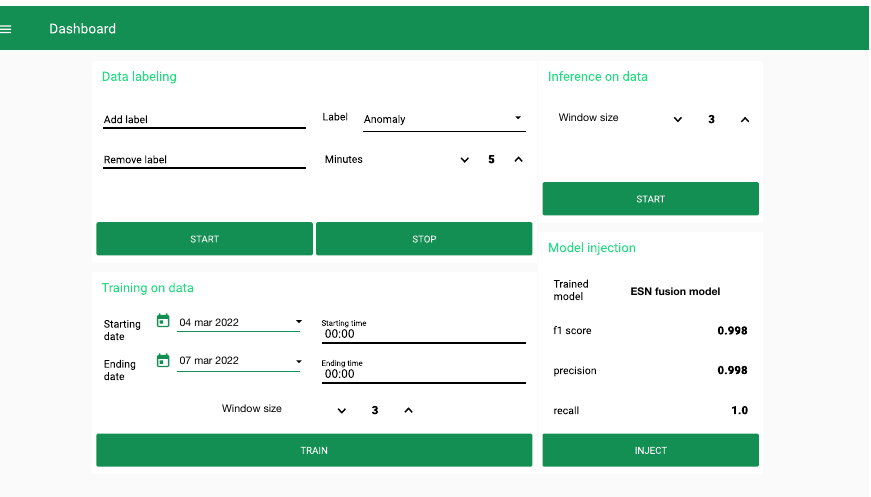
Figure 2. Dashboard running on the Cloud to orchestrate the Edge